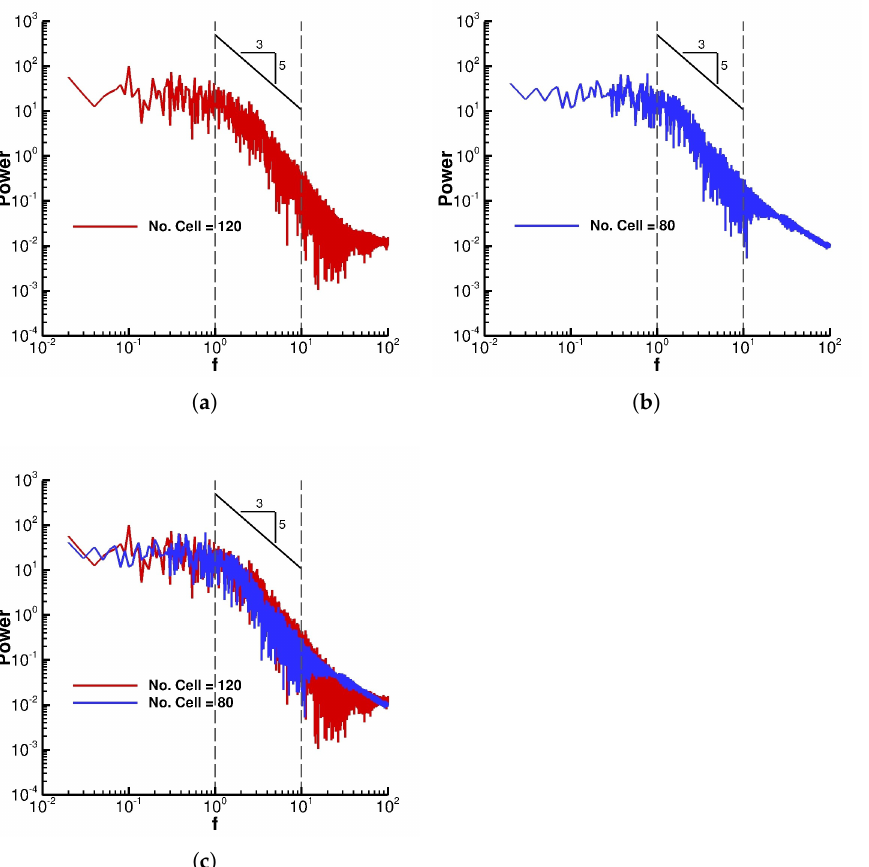
Figure 22. Energy spectra for condition No. 2 for two grids: ( a ) 120 cells in the wall normal direction inside the boundary layer. ( b ) 80 cells in the wall normal direction inside the boundary layer. ( c )